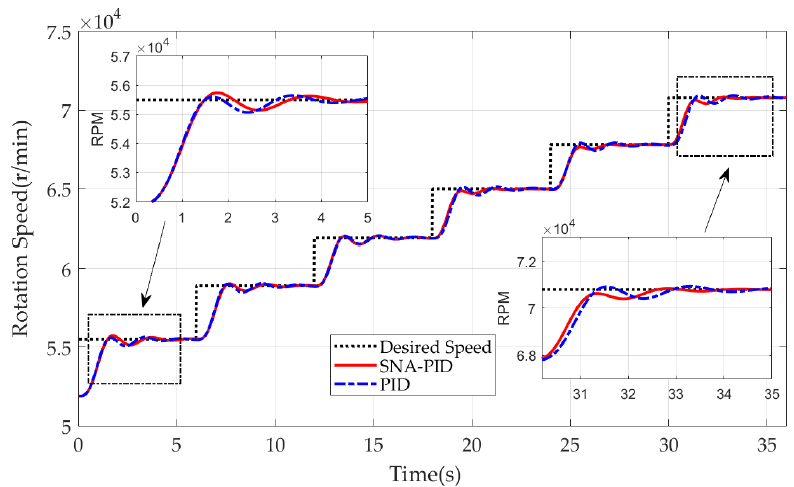
Figure 10. Tracking performance comparison between SNA-PID control and conventional PID control.